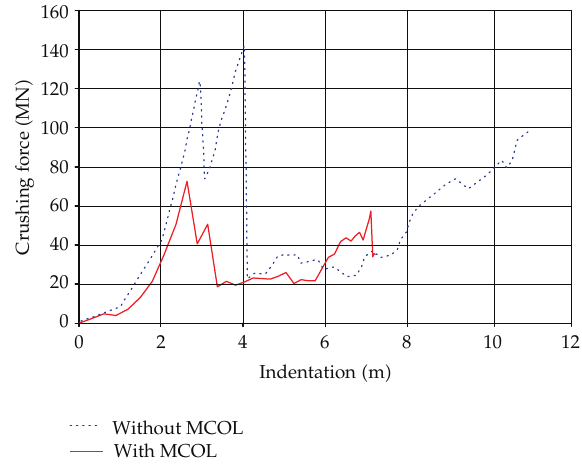
Figure 14: Crushing force with and without